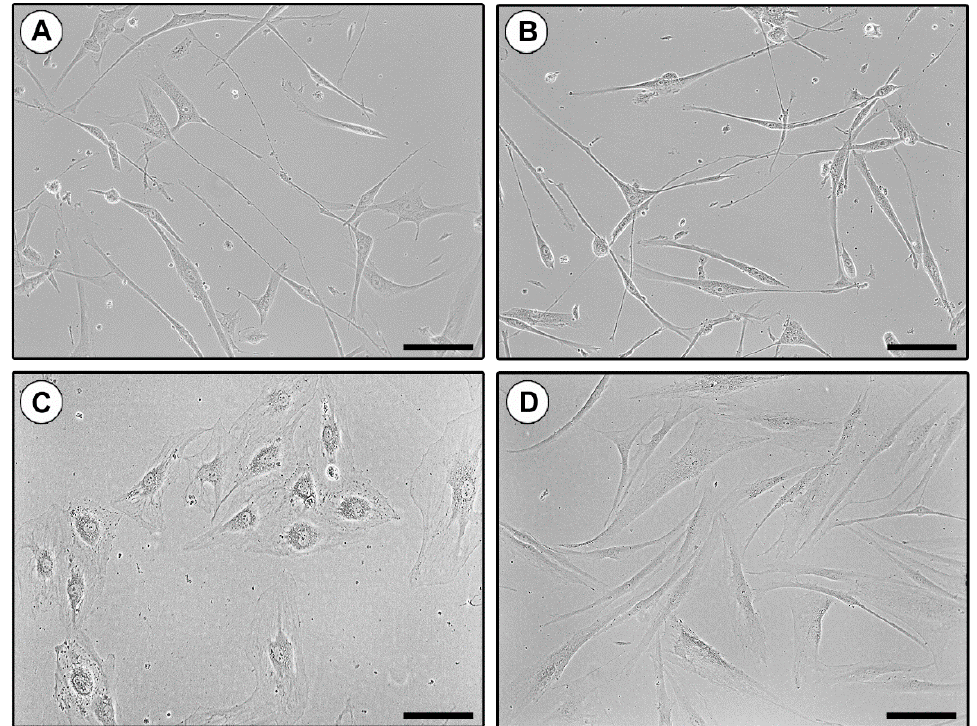
Figure 2. Morphologic assessment of in vitro cultured CD31 − /CD34+, CD31+, and CD31 − /CD34 − immunomagnetically selected cells by phase-contrast microscopy. ( A,B ) Representative phase-contrast microphotographs of CD31 − /CD34+ purified cells showing the distinctive telocyte morphology, with a small nucleated cell body giving rise to extremely long cytoplasmic prolongations with a moniliform appearance (i.e., telopodes). ( C ) Representative phase-contrast microphotograph of CD31+ isolated cells exhibiting the characteristic polygonal cobblestone-like morphology of ECs. ( D ) Representative phase-contrast microphotograph of CD31 − /CD34 − isolated cells presenting the typical spindle shape of fibroblasts. Original magnification: ×20 ( A–D ). Scale bar: 100 µm ( A–D ).